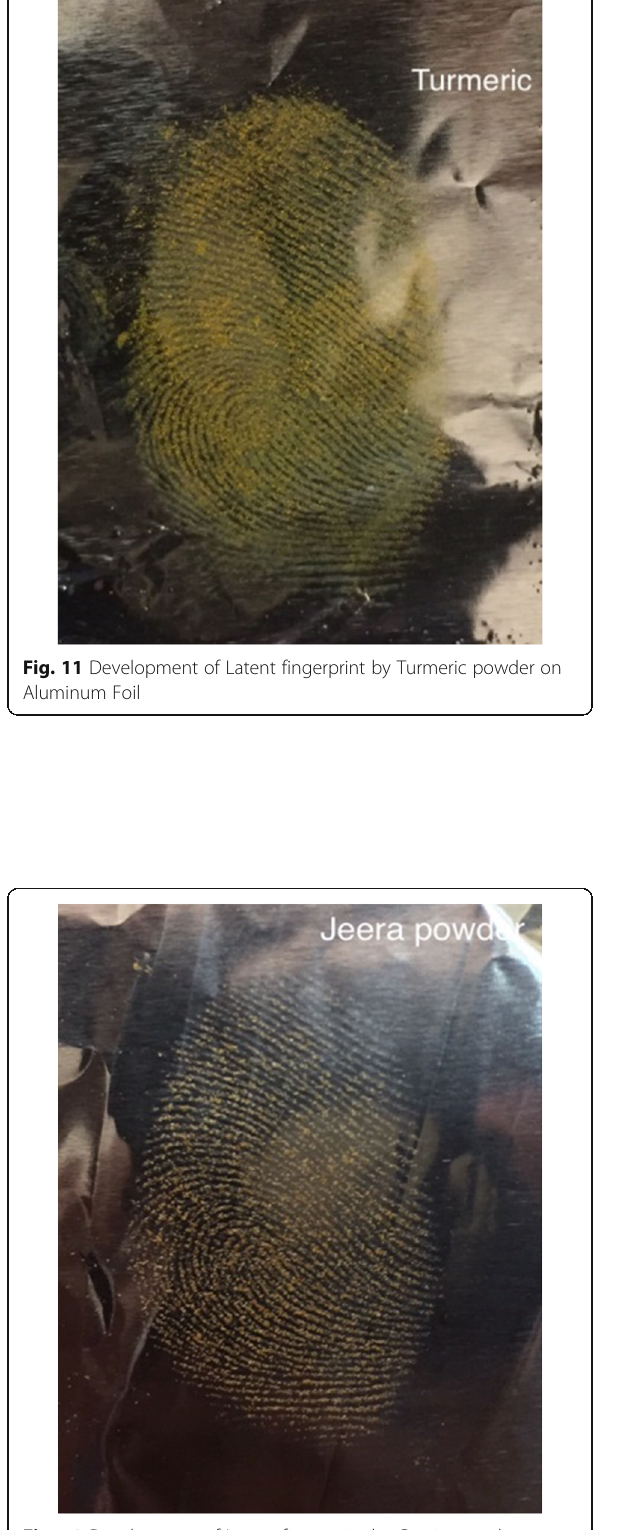
Fig. 14 Development of Latent fingerprint by Garam Masala powder on Aluminum